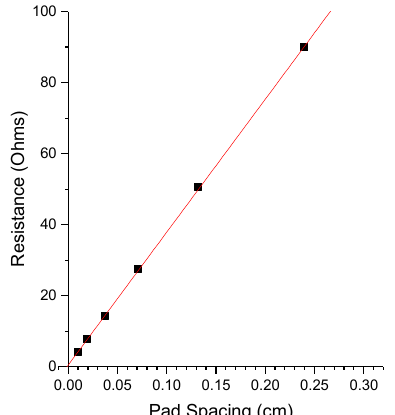
Figure 5. The measured resistance vs. the pad spacing to determine the sheet resistance and contact resistivity.